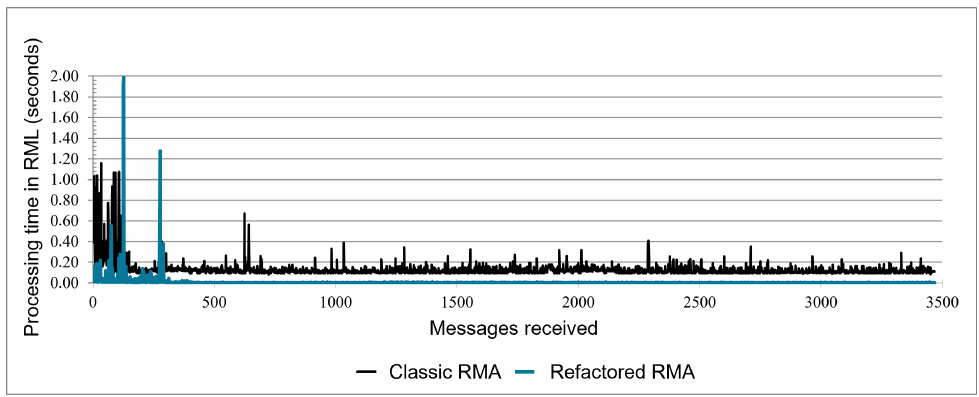
Figure 9. The comparison between RML’s message processing